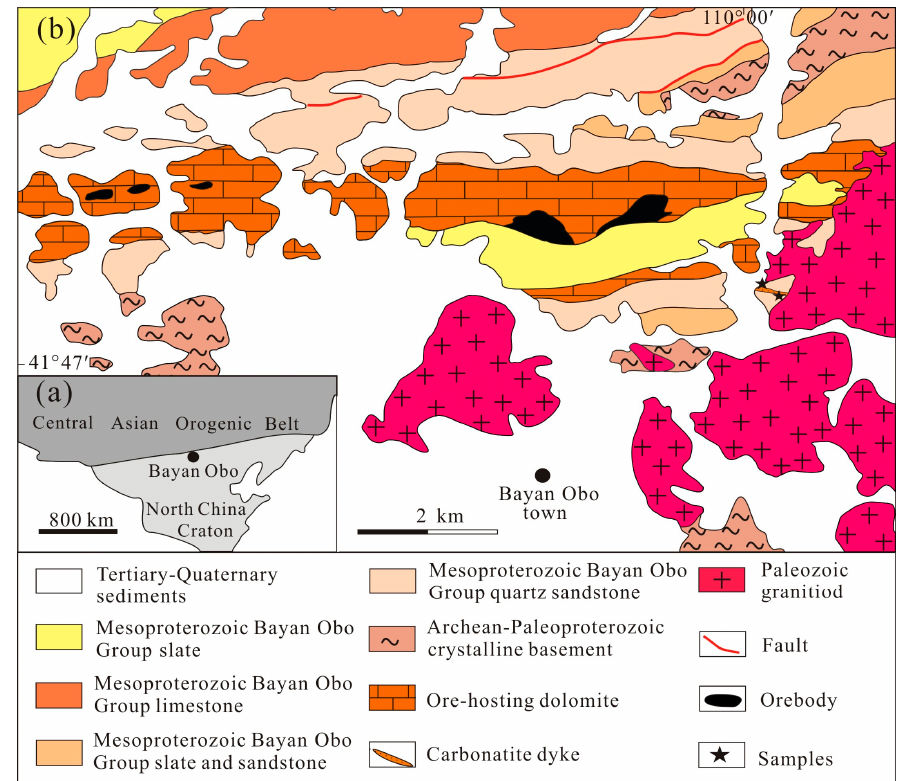
Figure 1. ( a ) Simplified map showing the tectonic location of the Bayan Obo deposit in the North China Craton (adapted from [21]); ( b ) Detailed geological map of the Bayan Obo rare earth element (REE) deposit (Modified from [1]).